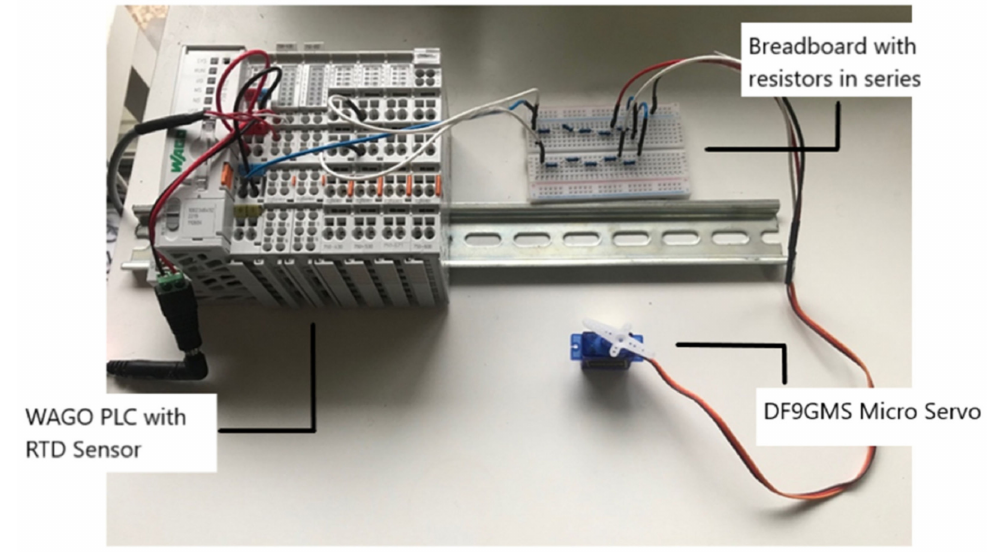
Figure 6. Physical setup of WAGO PLC, breadboard, and DF9GMS micro servo. e!Cockpit is the native integrated development environment (IDE) for the WAGO PLC, where the module code for initialising and running the sensor was completed. The code can be seen in Figure 7. OPC UA protocol was enabled on the PLC via e!Cockpit with the PLC’s IP address and port